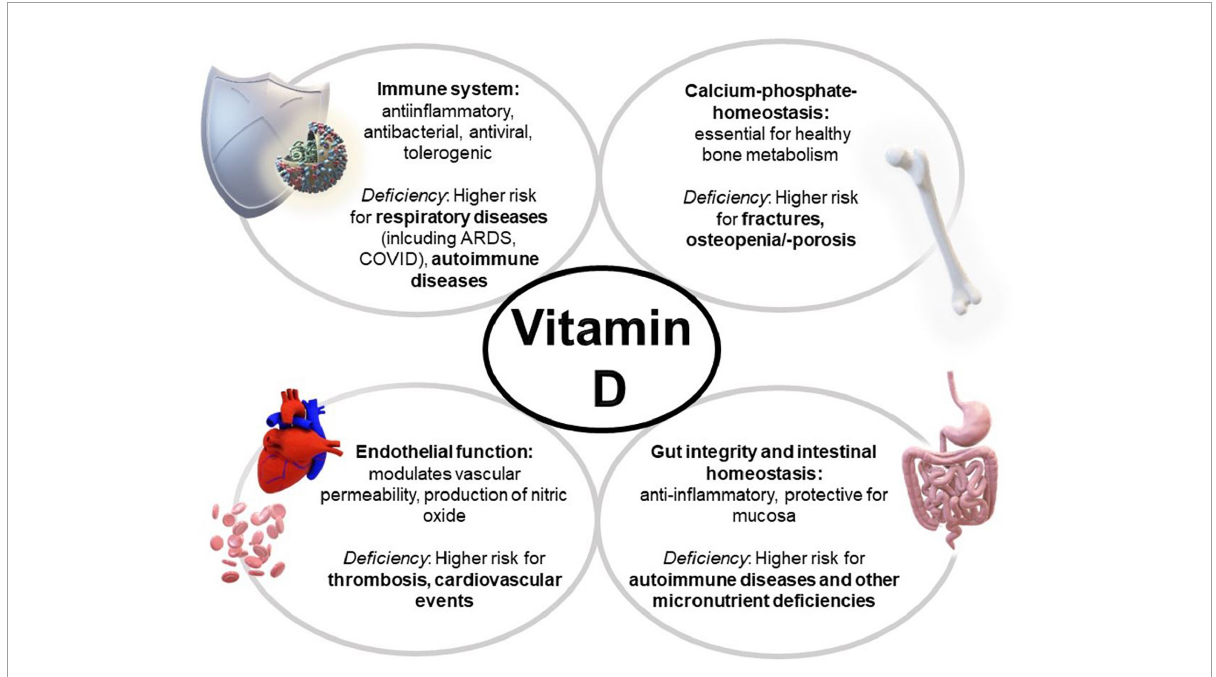
FIGURE1 Multiple effects of vitamin D and its deficiency on the body. ARDS, acute respiratory distress